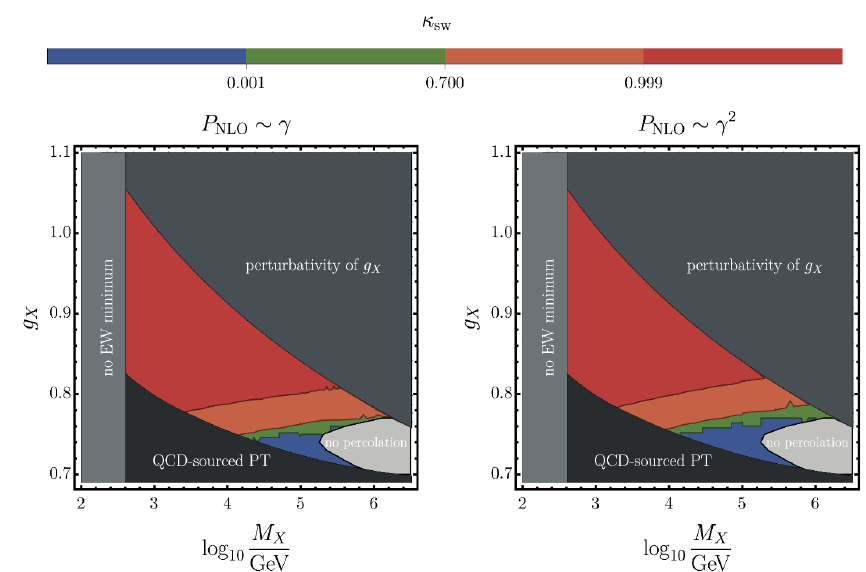
Figure 11 . The values of the efficiency factor κ sw of transferring energy of the PT into sound waves. The results were obtained by using the friction force of ref. [156] (left panel) and of ref. [155] (right